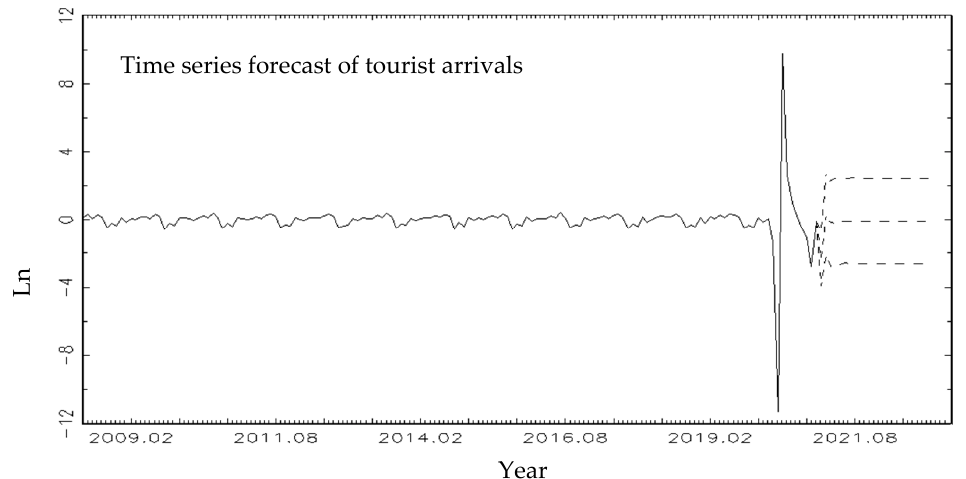
Figure 6. Forecast for tourist arrivals from January 2021 to December 2022. Sources: authors compilation based on Table 2.